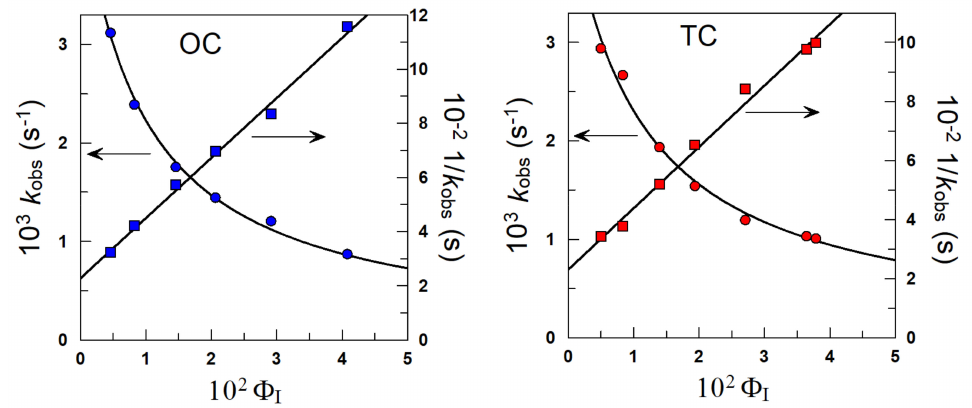
Figure 3. Variation of the observed rate constant k obs for the reaction of 16-ArN 2+ withOC and TC in in- tact 4:6 stripped corn oil-in-water emulsions. Experimental conditions: [16-ArN 2+ ] = 1.03 × 10 − 4 M,